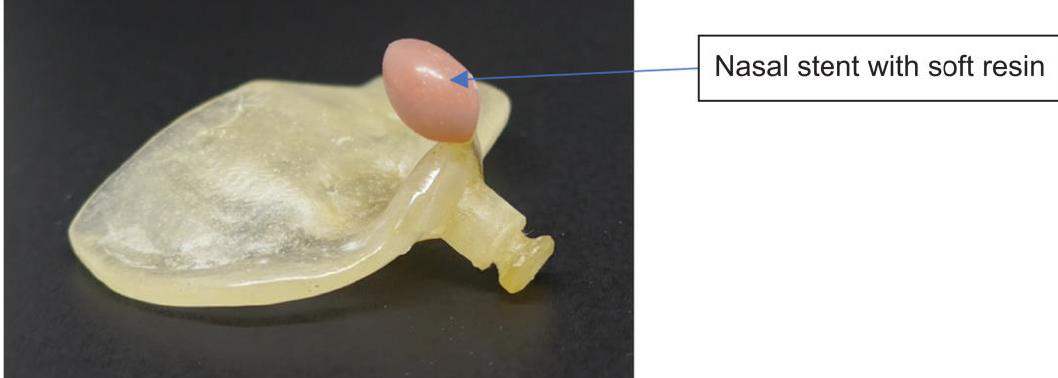
Figure 7. Nasal stent with molding plate used at our hospital.